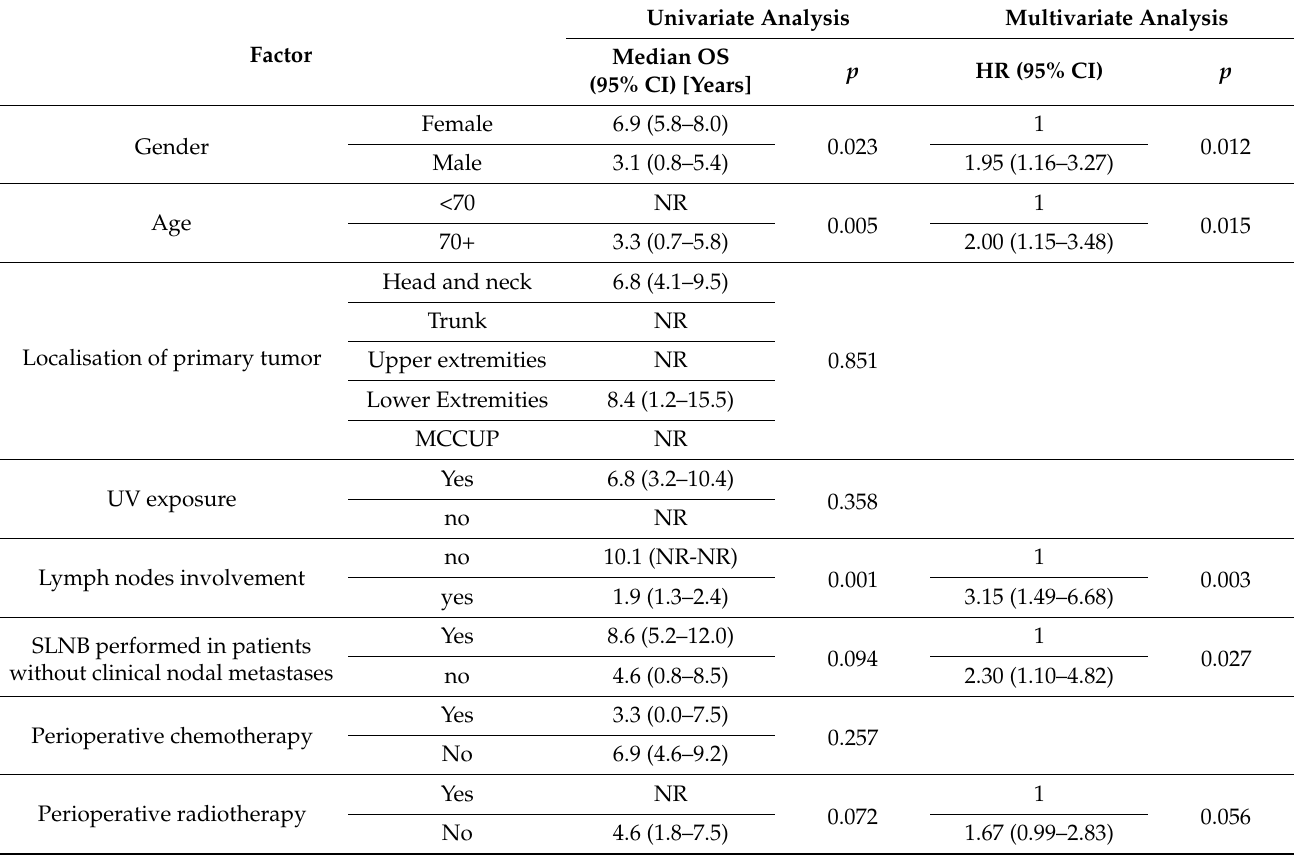
Table 3. Univariate and multivariate analysis of factors associated with overall survival. Univariate Analysis Multivariate Factor